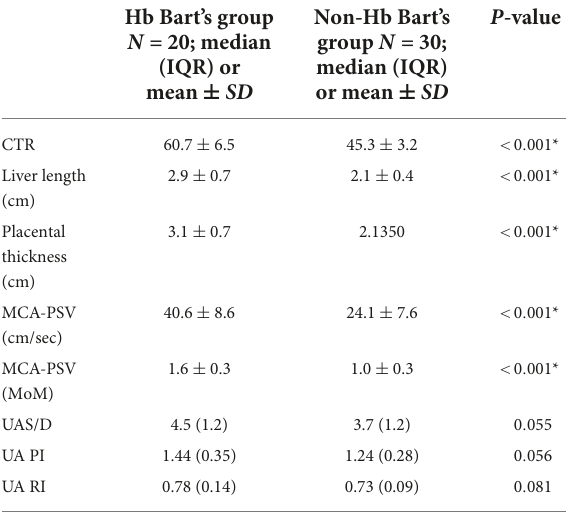
TABLE 3 Comparisons of fetal cardiac function of both